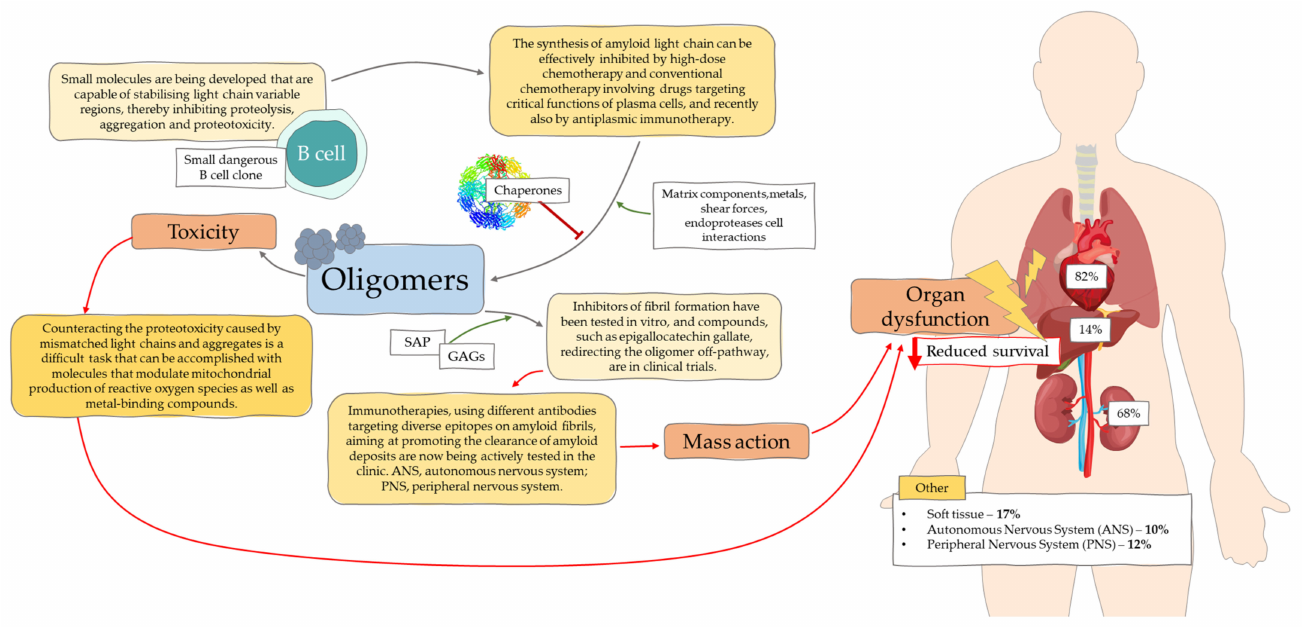
Figure 1. Schematic depicting the molecular mechanisms leading to light chain amyloidosis [based on [11]]. SAP, serum amyloid P; GAGs, glycosaminoglycans; ANS, autonomous nervous system; PNS, peripheral nervous